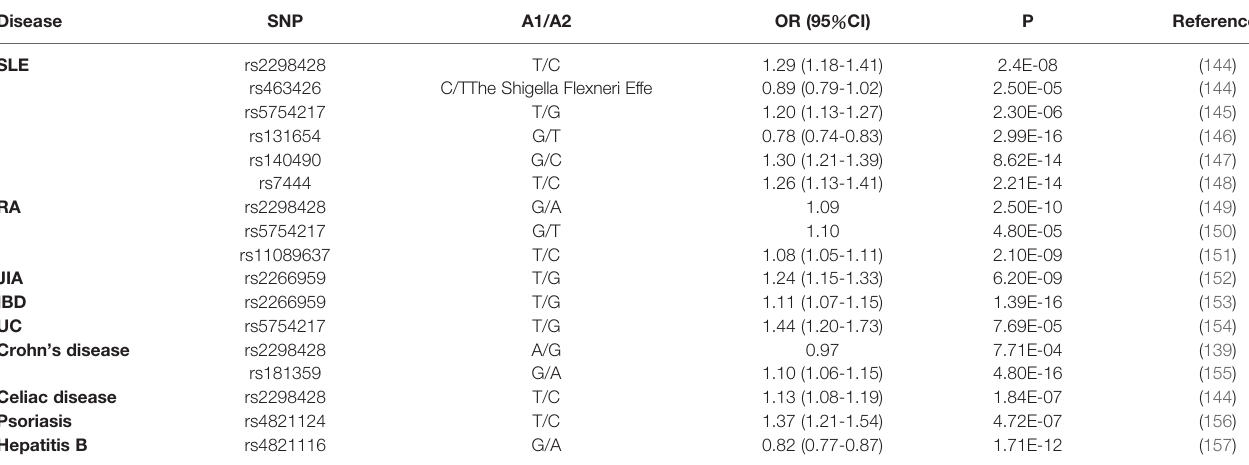
TABLE 2 | Genetic studies showing an association between UBE2L3 and autoimmune and infectious diseases.